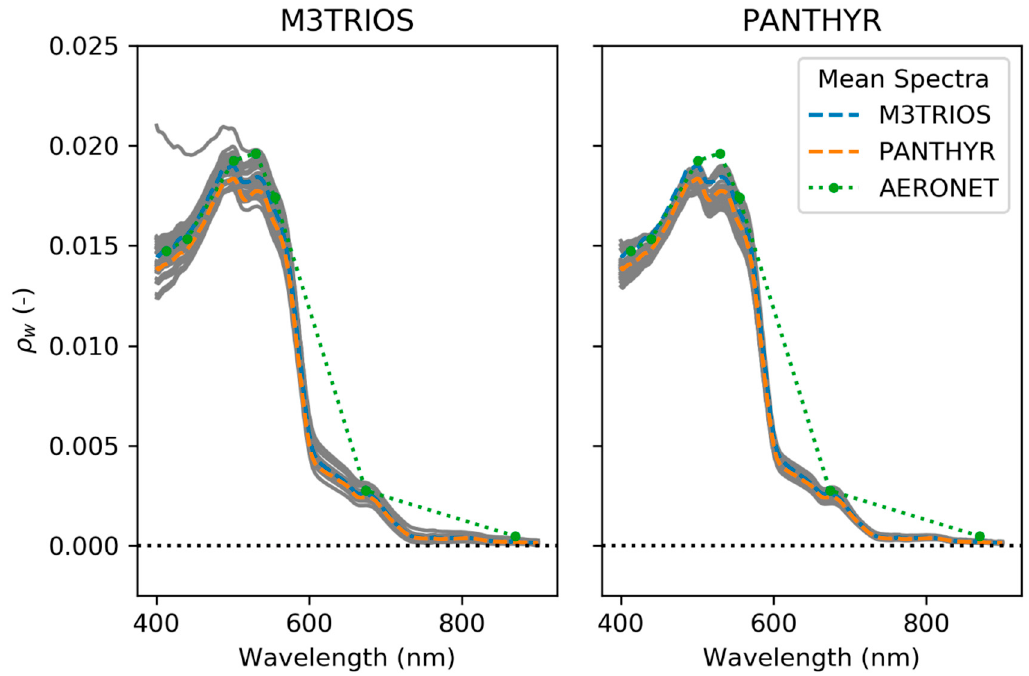
Figure 6. Water reflectance spectra for each of the 30 stations (gray lines) from (left) the three-radiometer TRIOS / RAMSES system (M3TRIOS) system and (right) the PANTHYR system. Mean spectra over all 30 stations are superimposed for the PANTHYR (orange dashed line) and the M3TRIOS system (blue dashed lines) and for all 10 measurements from the AERONET-OC system (green dotted line joining dots where the multispectral data